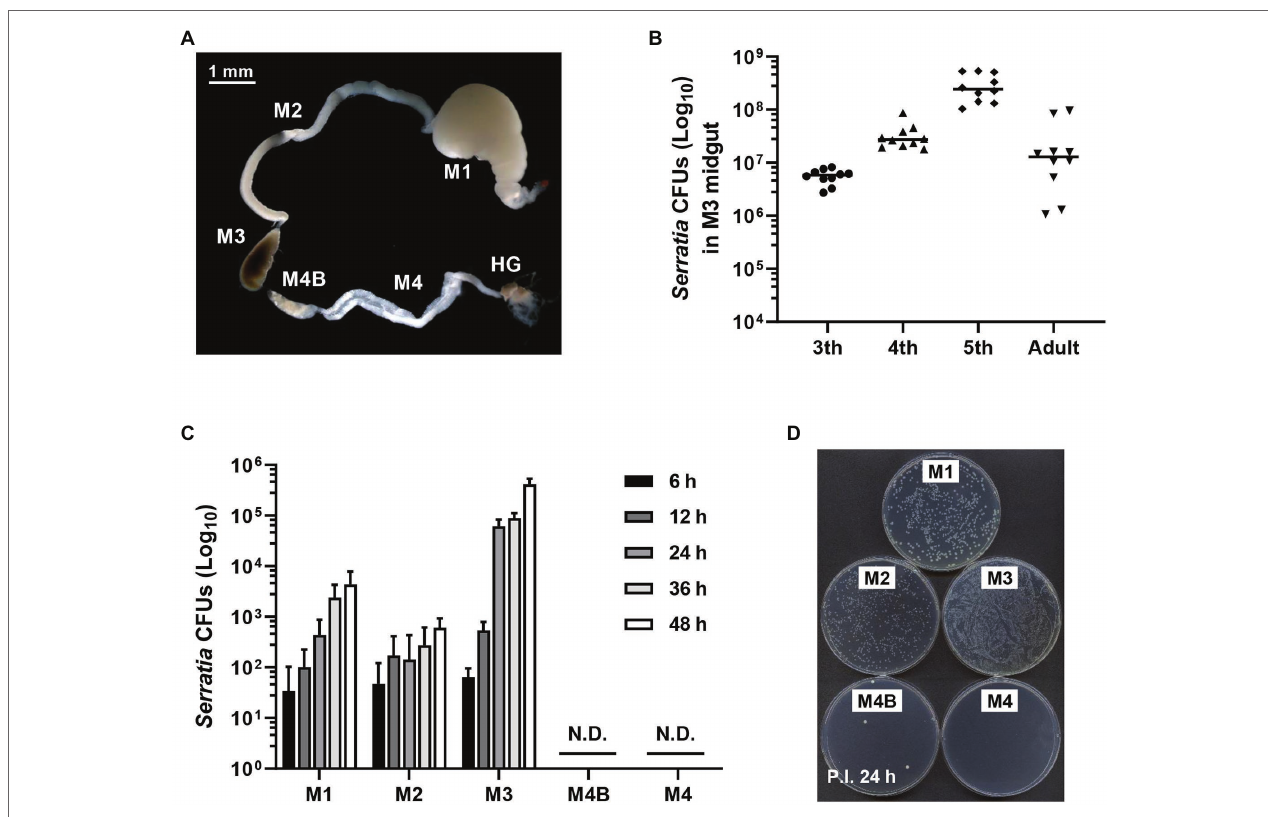
FIGURE 1 | Colonization of orally infected Serratia marcescens . (A) Midgut (M1, M2, M3, M4B, and M4) and hindgut (HG) regions of the Riptortus pedestris insect. (B) Infection density of S. marcescens at third, fourth, fifth-instar stages and male adults. Means and standard deviations (SDs; n = 10) are shown as columns and error bars, respectively. (C) Colony-forming unit (CFU) quantification of infection densities of S. marcescens Db11 cells at 6, 12, 24, 36, and 48 h after inoculation. Horizontal lines in the graph indicate the mean values of S. marcescens CFUs. Error bars indicate the SD of the mean ( n = 10). (N.D., not detected). (D) Colonies on agar plate of S. marcescens cells at an early stage of